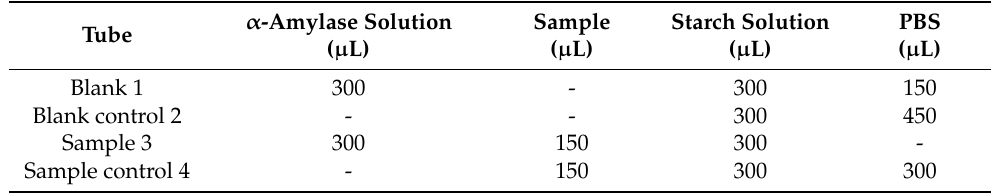
Table 5. Inhibition system of α -amylase